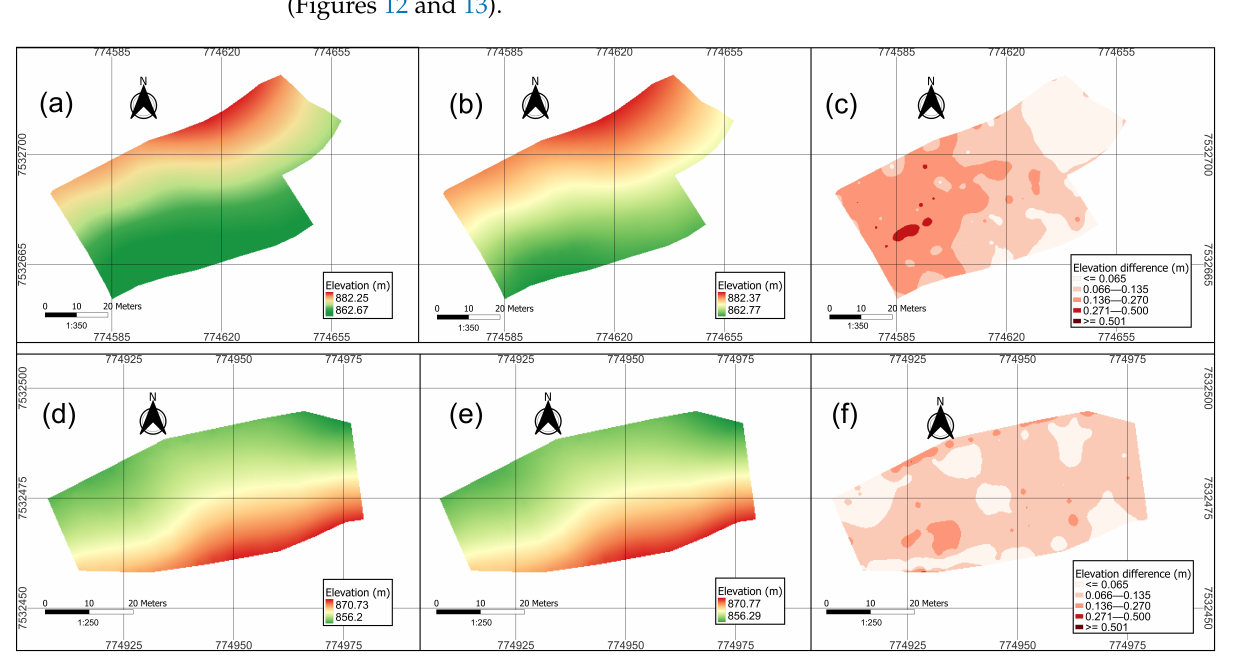
Figure 12. DEMs for areas 1 and 2 and the differences of DEM from both methodologies: ( a ) DEM of area 1, obtained by conventional topographic survey; ( b ) DEM of area 1, obtained using RPA; ( c ) altimetric difference between DEMs ( a , b ). ( d ) DEM of area 2, obtained by conventional topographic survey; ( e ) DEM of area 2, obtained using RPA; ( f ) altimetric difference between DEMs ( d,e ).